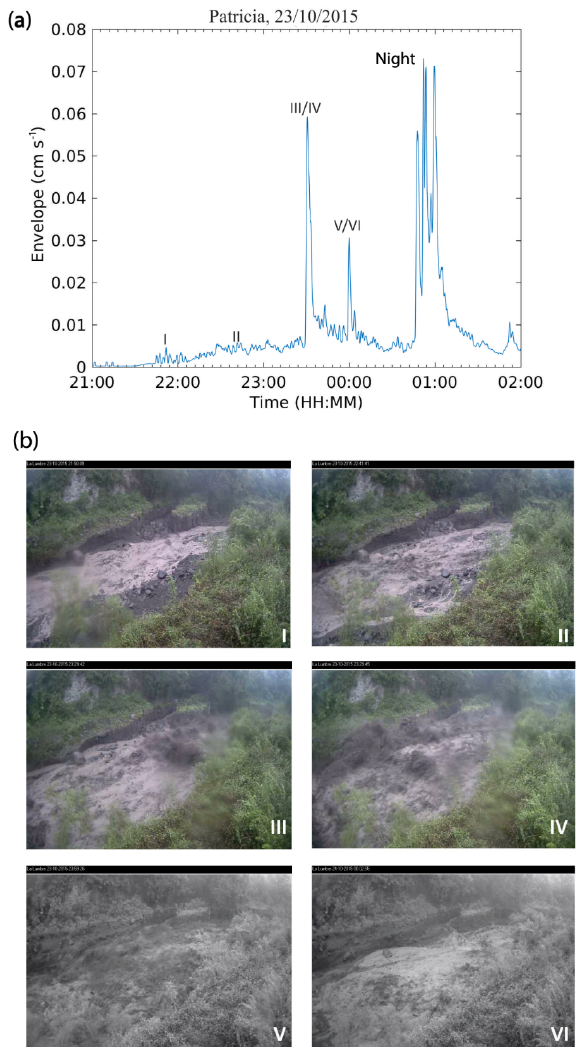
Figure 8. (a) Seismic record of the lahar triggered during Hurricane Patricia, on 26 October 2015, recorded along La Lumbre ravine. The main lahar pulses are indicated with roman numerals. (b) Im- ages captured by the camera, corresponding to the main pulses, as indicated in panel (a)